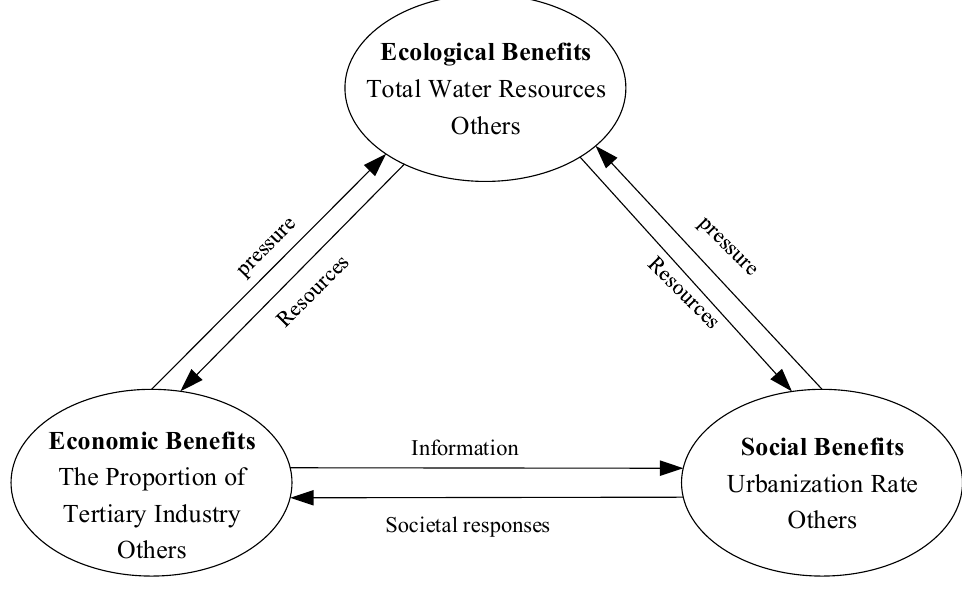
Figure 2. Ecological-Social-Economic (ESE) Framework.